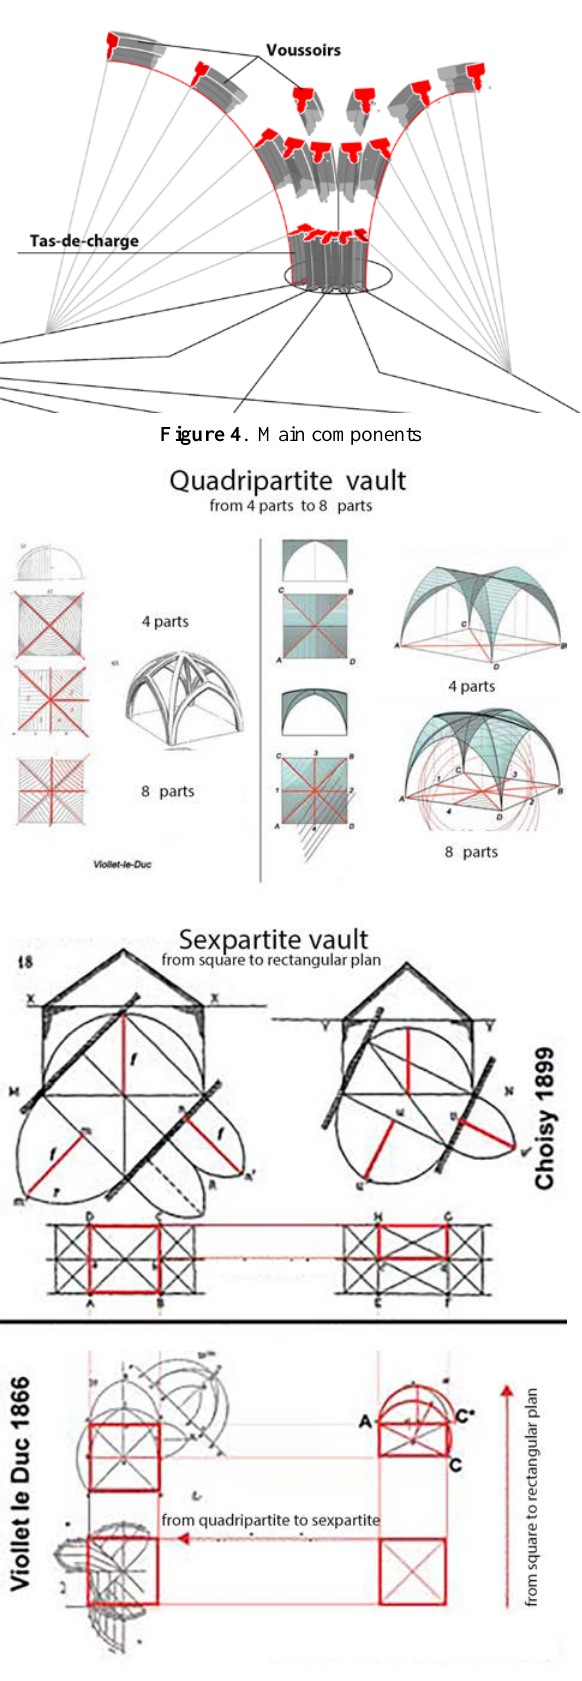
Figure 5 . ribbed vaults evolution from literature: